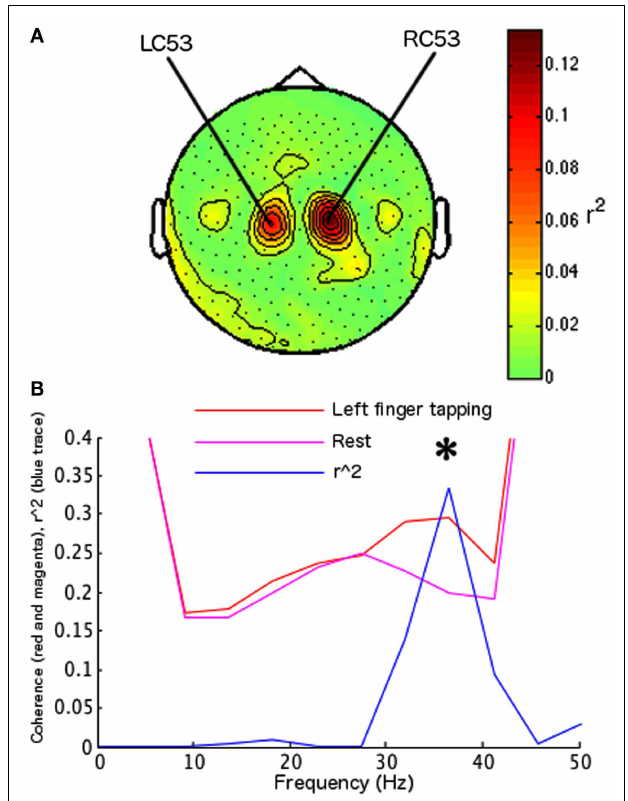
FIGURE 3 | Parameter identification for subject 2. Same convention as Figure 2 . (A) Topographic map of determination coefficients between left hand versus right hand movements at the frequency used to identify sensors related to the SMR.These sensors were used during behavior identification and during feedback testing. (B) Plot of the largest regression values for subject 2 during behavior identification, indicating the frequencies at which the difference in coherence between the behaviors of interest was largest. Left index finger tapping versus rest elicited the largest determination coefficient (determination coefficients for other behavior pairs not shown).The frequency with largest determination coefficients was used in feedback testing for this subject, and the identified behaviors were used to control